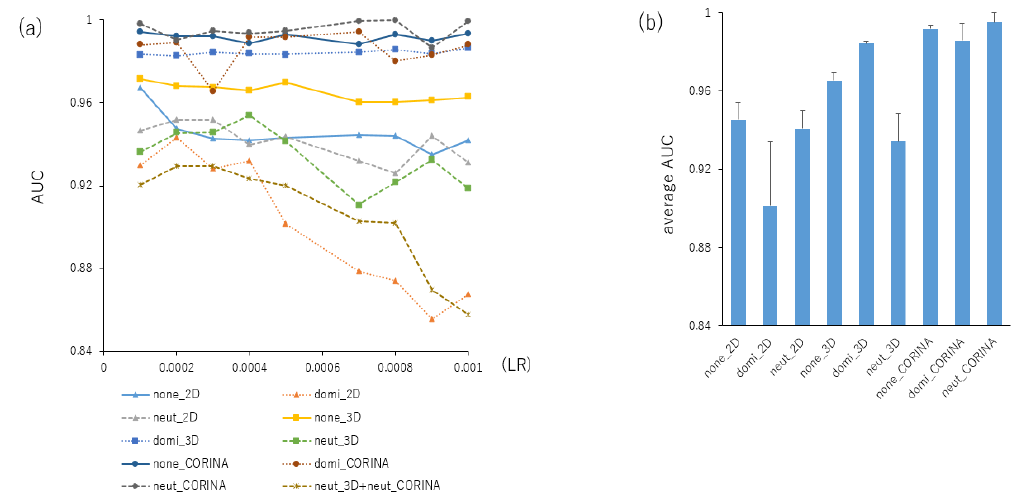
Figure 2. A contribution of the performance of prediction models with different wash conditions in the preparation of chemical structures of molecular operating environment (MOE) software. In the preparation for 3D chemical structures using MOE software, combinations of three kinds of protonation (none, dominate, and neutralize) and coordinates (2D, 3D, and CORINA) were utilized. The image produced by DeepSnap had the following angles and parameters: (176°, 176°, 176°), MPS:100, ZF:100, AT:23%, BR:14.5 mÅ, BMD:0.4 Å, BT:0.8 Å using nonoverlapped samples (Tra:Val:Test = 16:16:1) of the build DL-based prediction model by GoogLeNet from LR:0.001 to 0.0001 ( a ). The averages of AUCs of each LR were calculated ( b ).